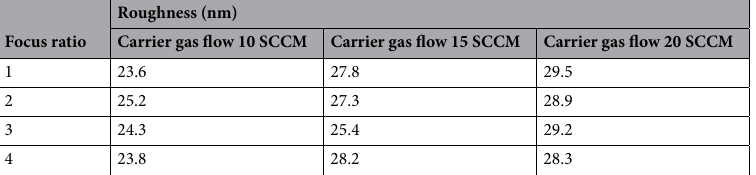
Table 1. Roughness of SPIONs tracks. The roughness was determined from R a = ( 1 )/( N ) (cid:31) | Z i − z | from 10 μm × 10 μm AFM scans.